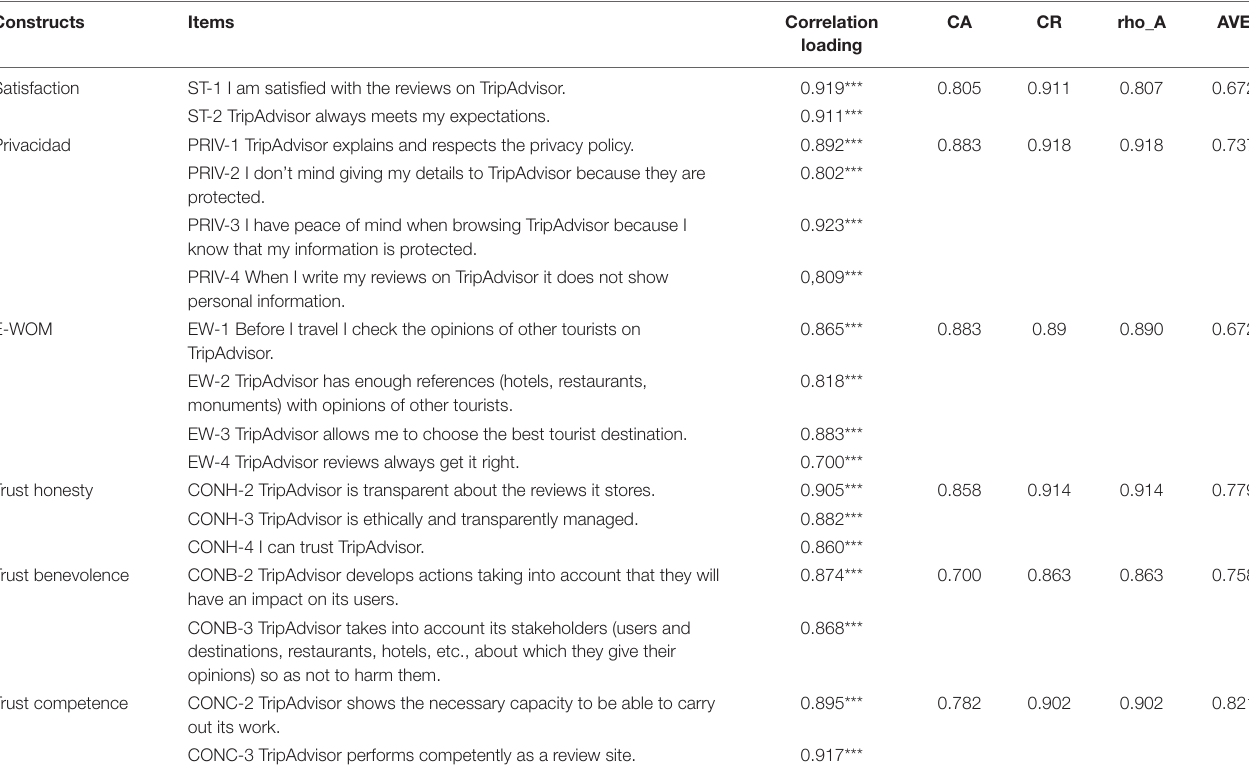
TABLE 2 | Measurement items first